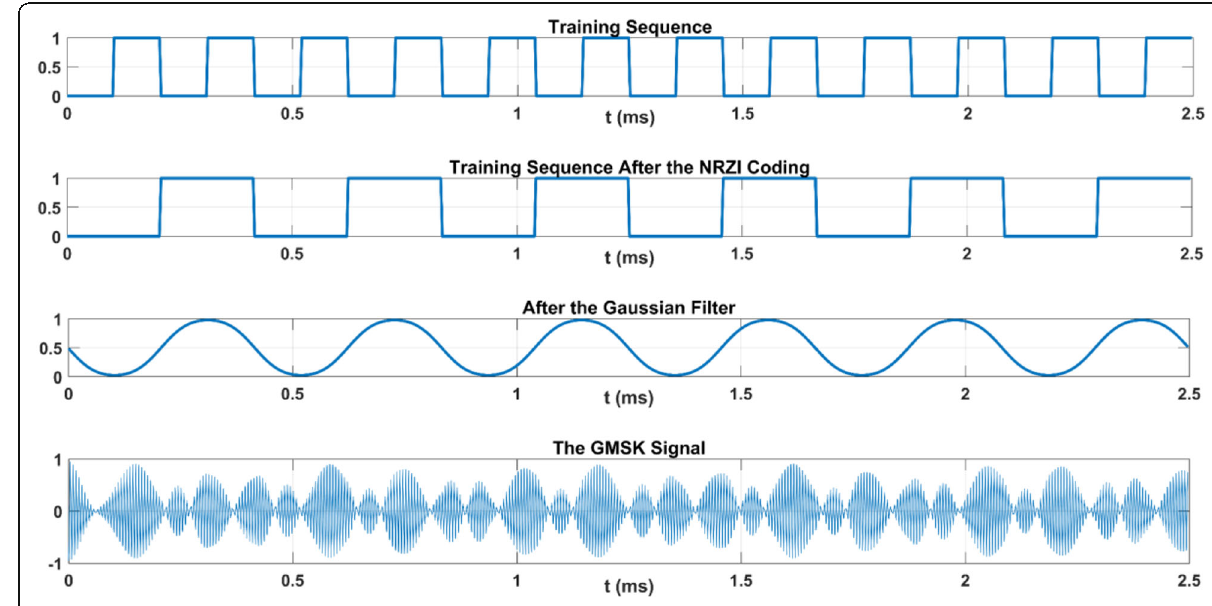
Fig. 3 Training sequence: the training sequence of AIS signal at different stages